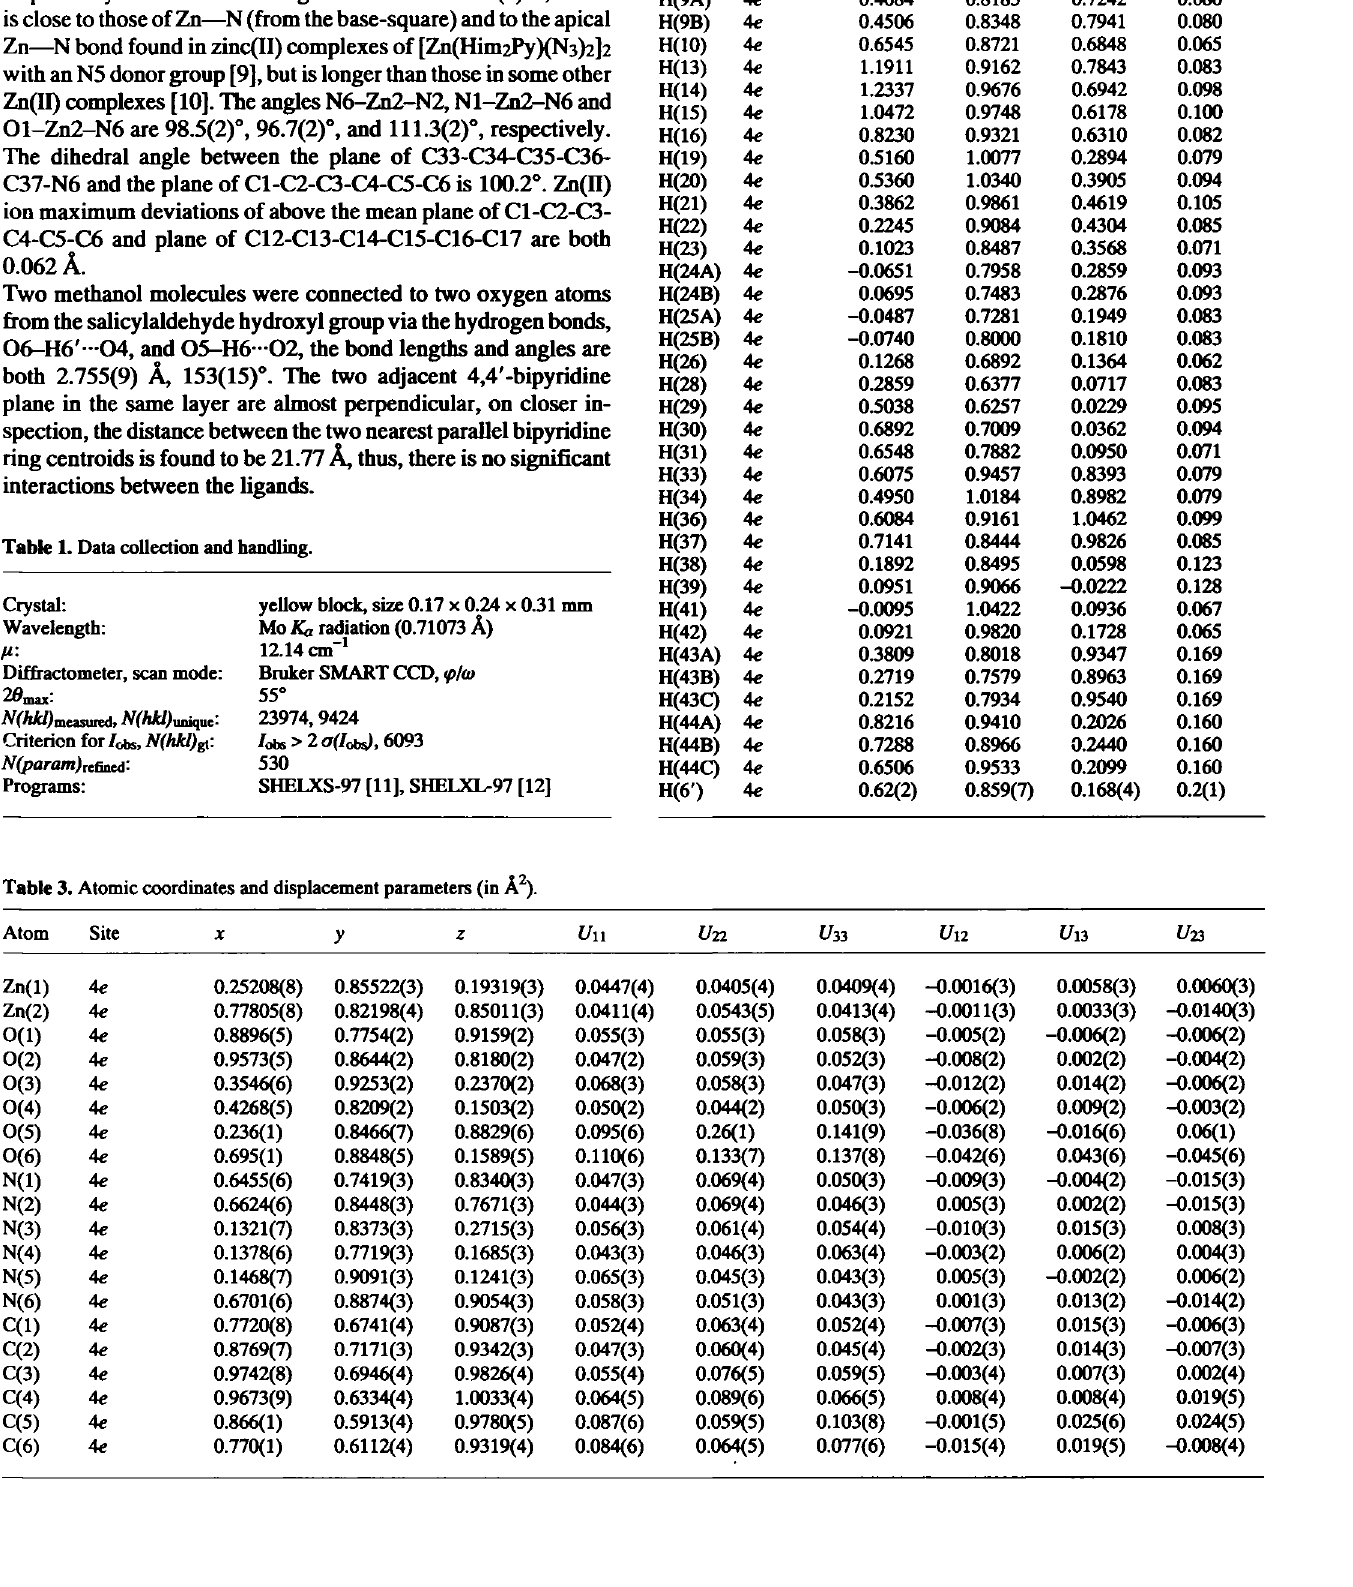
Table 1. Data collection and handling.